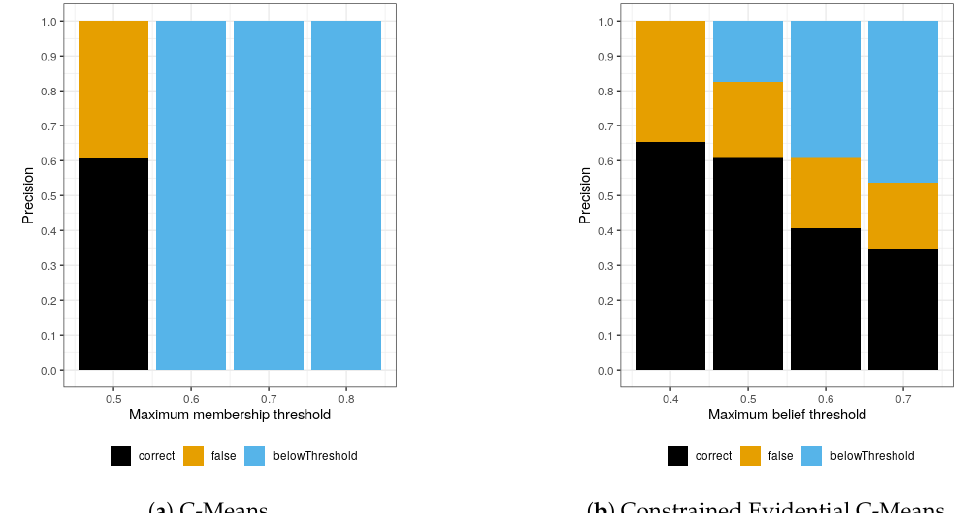
Figure 4. Results of noisy living lab tracks clustering with C-Means and Constrained Evidential C-Means and filtering over cluster membership grades (C-Means) and normalized beliefs